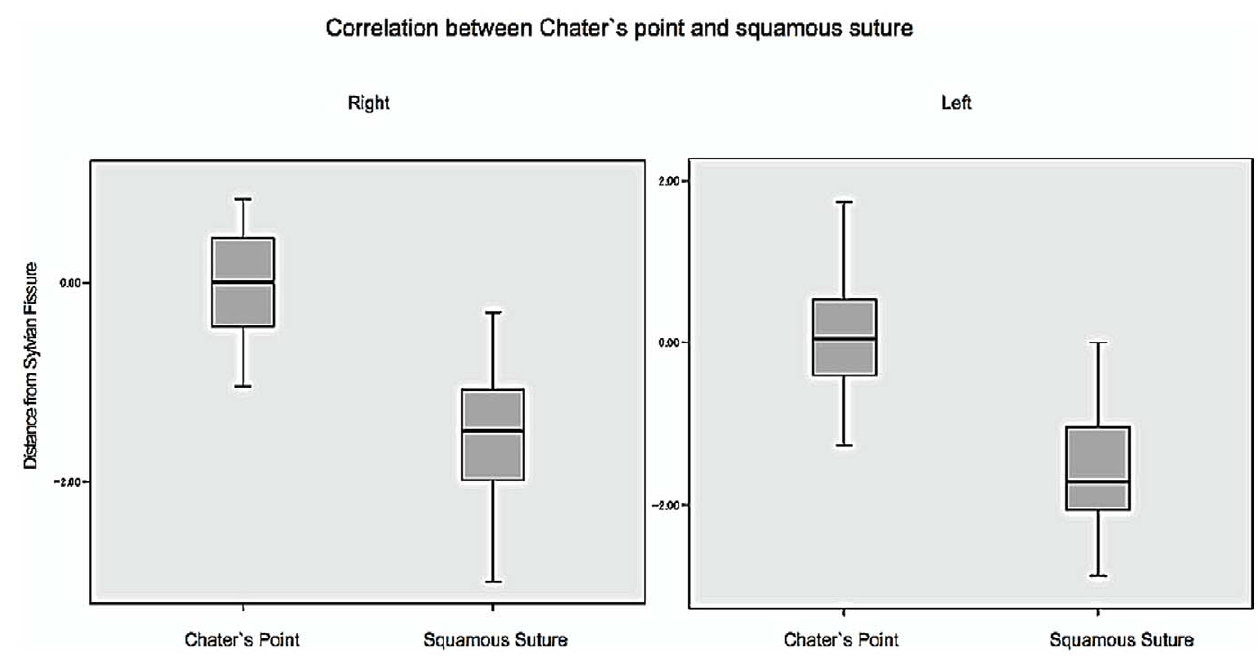
Figure 5. Correlation between Chater’s point and Squamous suture.